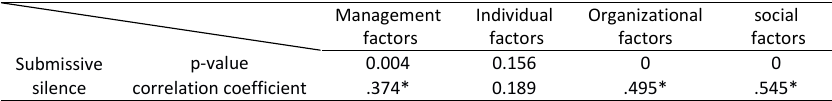
Table 7. The test of the correlation between submissive silence variables and silent factors